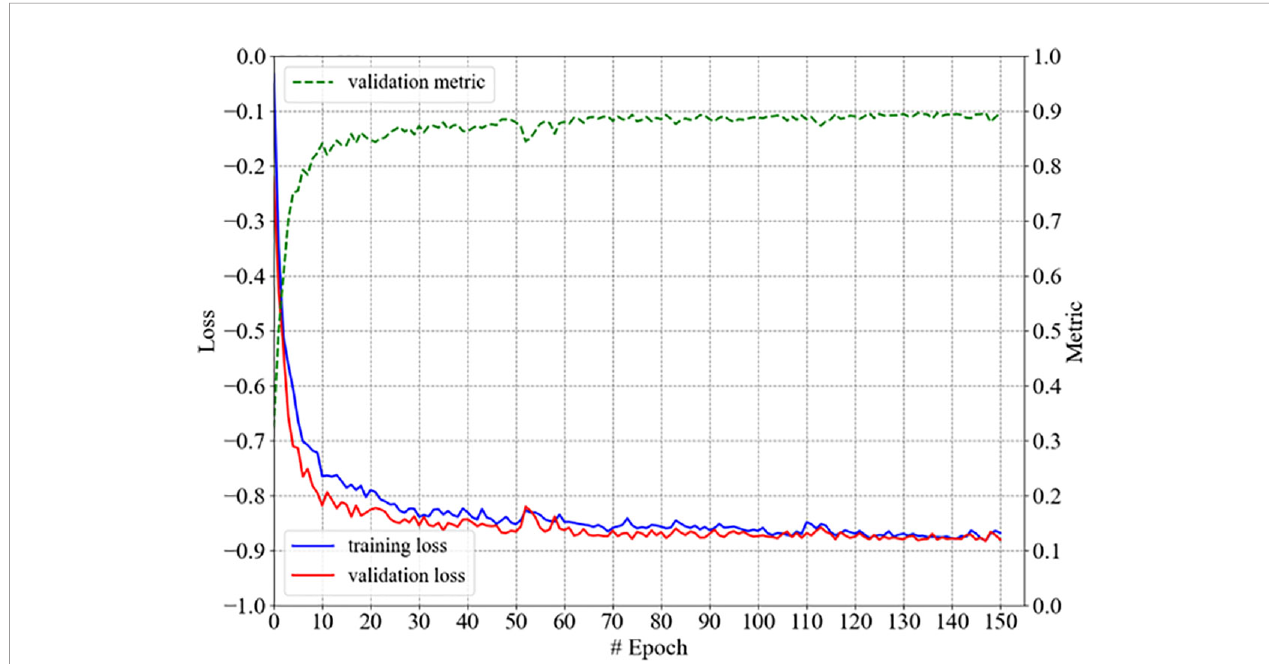
FIGURE 3 | The training process of model-hippo: the loss is the objective loss L and the metric is